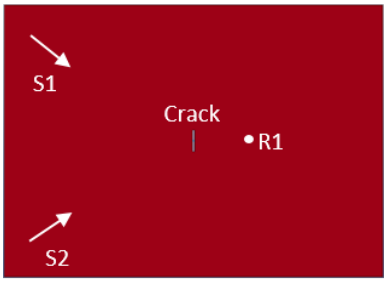
Figure 5. LS-DYNA model.